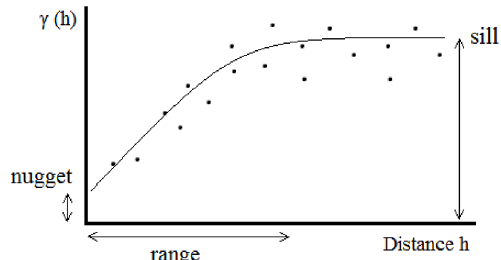
Figure 8. Idealized variogram with the parameters nugget, sill and range (after Deutsch and Journel, 1998). See description in the